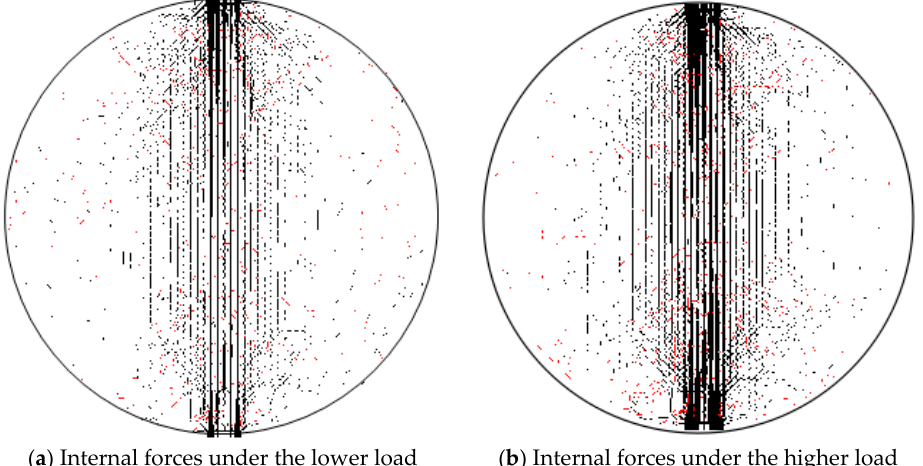
Figure 7. Internal forces distribution at early loading stage.